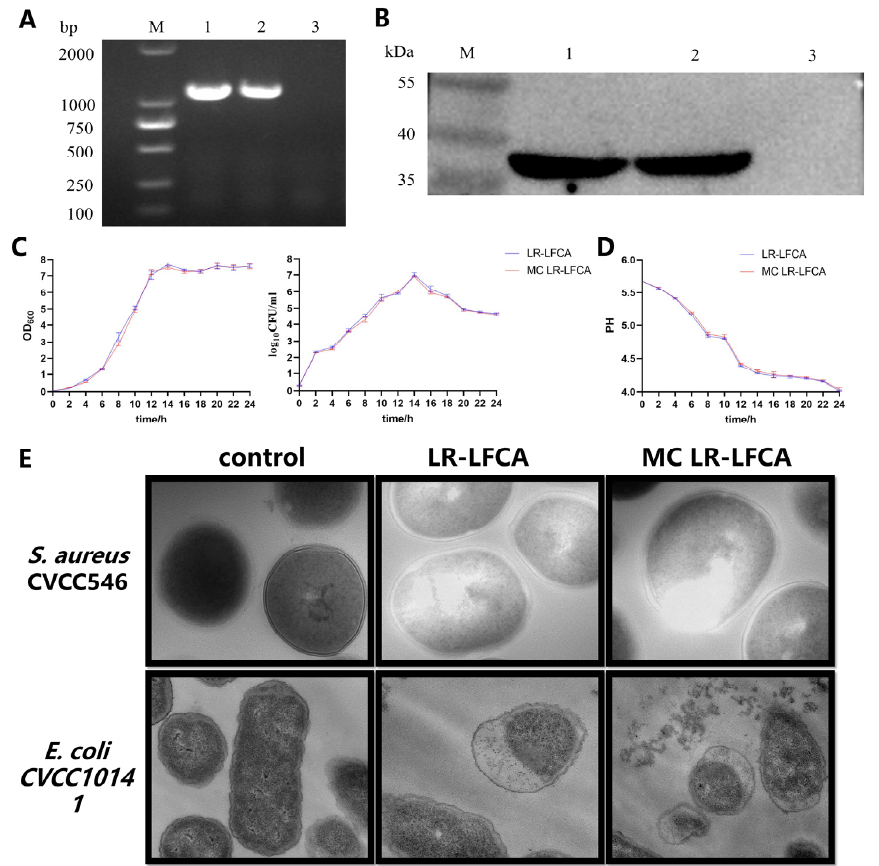
Figure 6. Protein expression, growth curves, and antimicrobial activity of microencapsulated LR- LFCA. ( A ) Identification of the recombinant plasmid pPG-LFCA-E and PCR products of approximately 1200 bp. 1: LR-LFCA. 2: MC LR-LFCA. 3: LR-CON. ( B ) LFCA-E protein expression was analyzed using western blotting, which resolved an immunoreactive band at 38 kDa. LR-LFCA, MC LR-LFCA, and LR-CON were cultured for 24 h, and the LFCA-E protein expression levels were as-